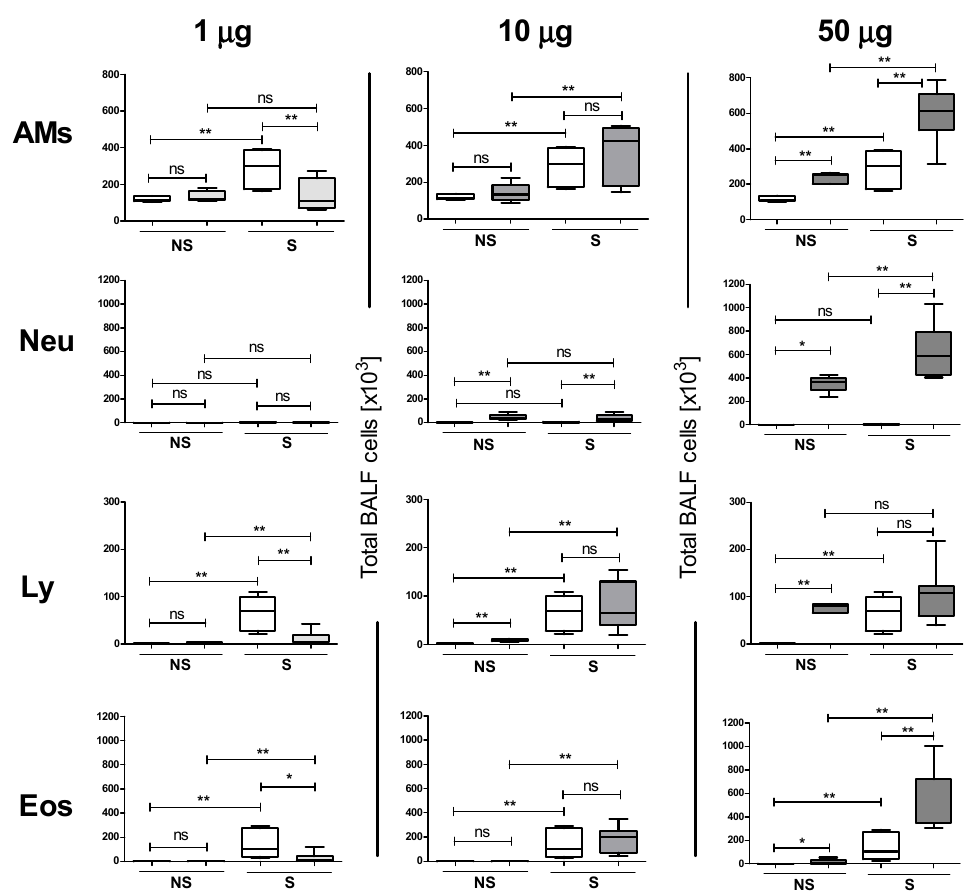
Figure 2. Ag50-PVP NPs exert dose-dependent effects in vivo. Bronchoalveolar lavage fluid ( BALF) cell analysis. In each graph, on the left are non-sensitized mice (NS) and on the right sensitized (S) mice. White plots represent particle-free supernatant (SUP) controls and filled plots depict NPs-treated lungs. The dose is given above. AMs, alveolar macrophages; Neu, neutrophils; Ly, lymphocytes and Eos, eosinophils. ( n = 5–8/group) * p < 0.05, ** p < 0.01; ns, not significant.